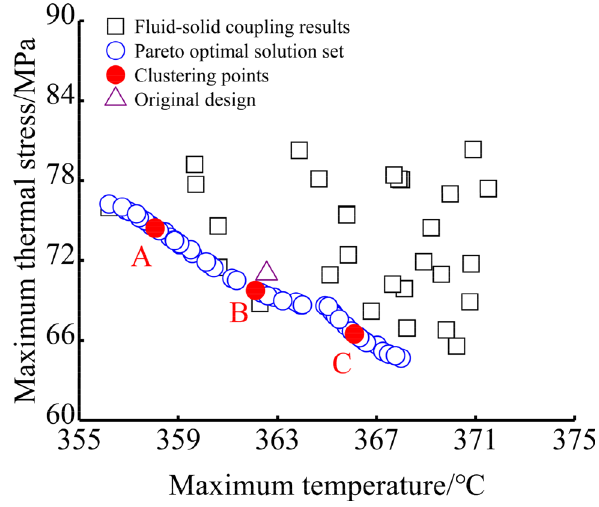
Figure 9. Distribution of clustering points in Pareto optimal solution set.